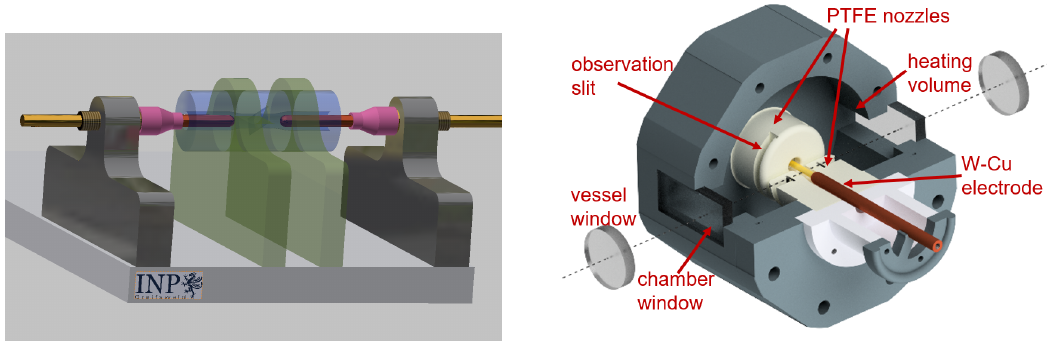
Figure 2. Left : Setup (a) was used under ambient conditions (no external chamber). Right : Setup (b) was part of a model circuit breaker placed inside a pressure vessel with vessel windows and the quartz plates in the observation slits. The dotted line indicates the sight through the outer